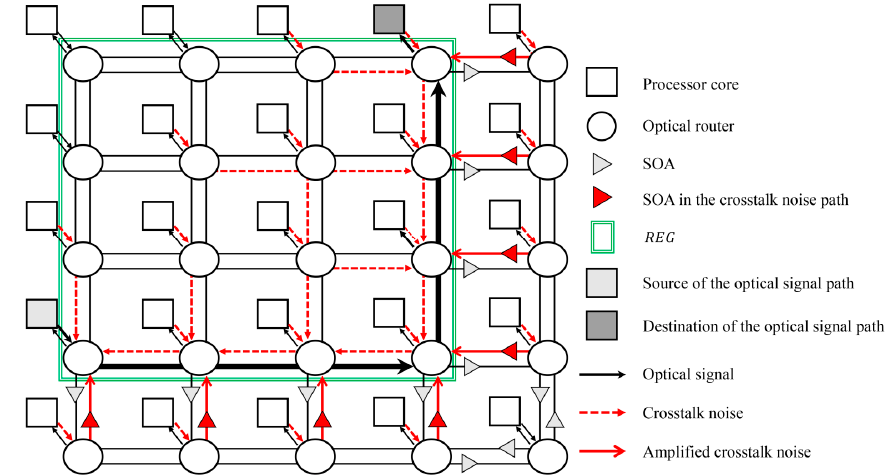
Figure 9. Worst-case signal to noise ratio (SNR) of the non-SOA region surrounded by SOA-placed